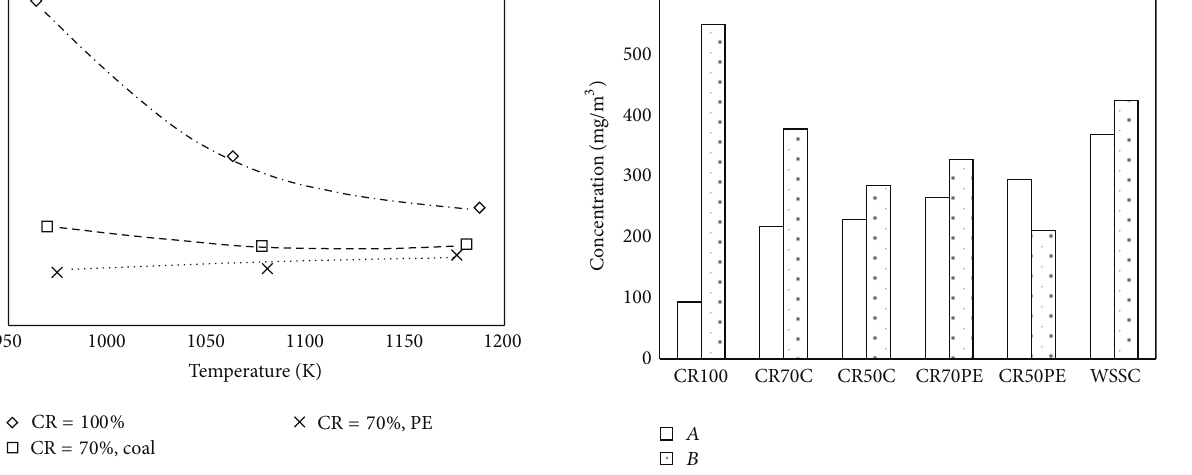
Figure 4: Influence of furnace temperatures on NO emission.